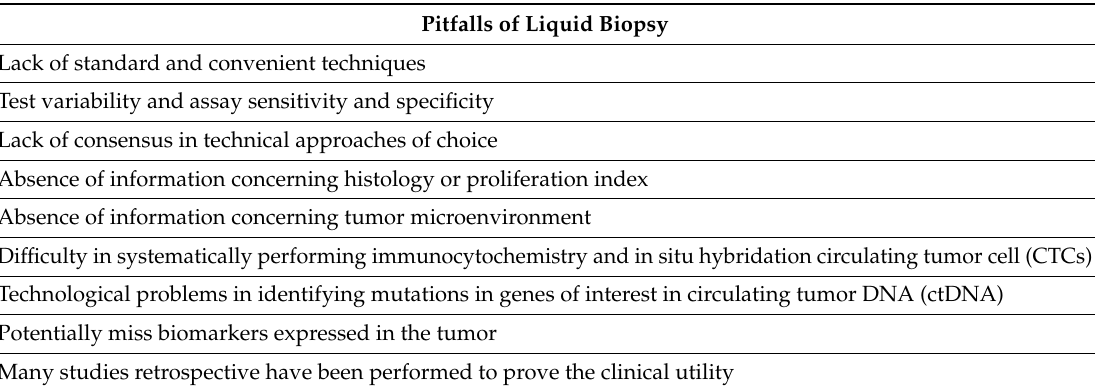
Table 3. Pitfalls of liquid